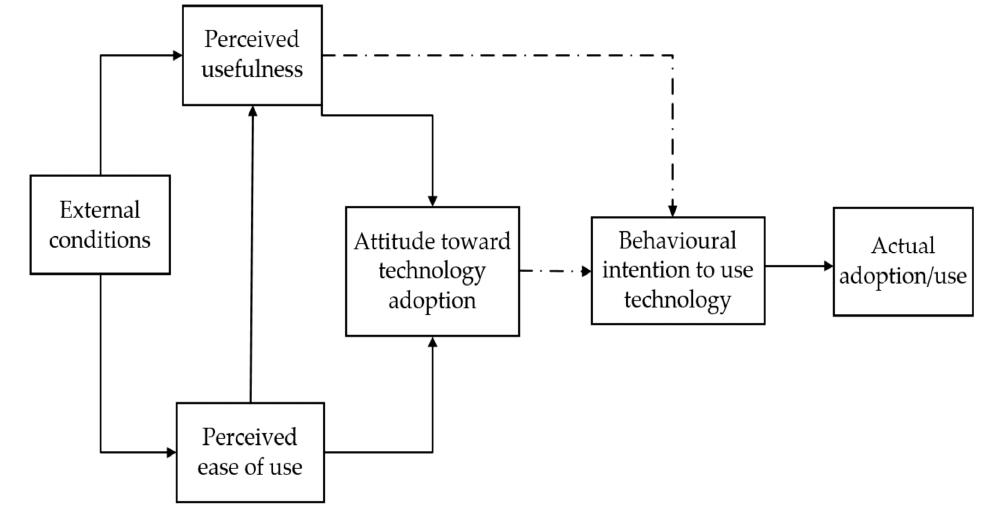
Figure 1. Technology acceptance model (Davis, 1989).